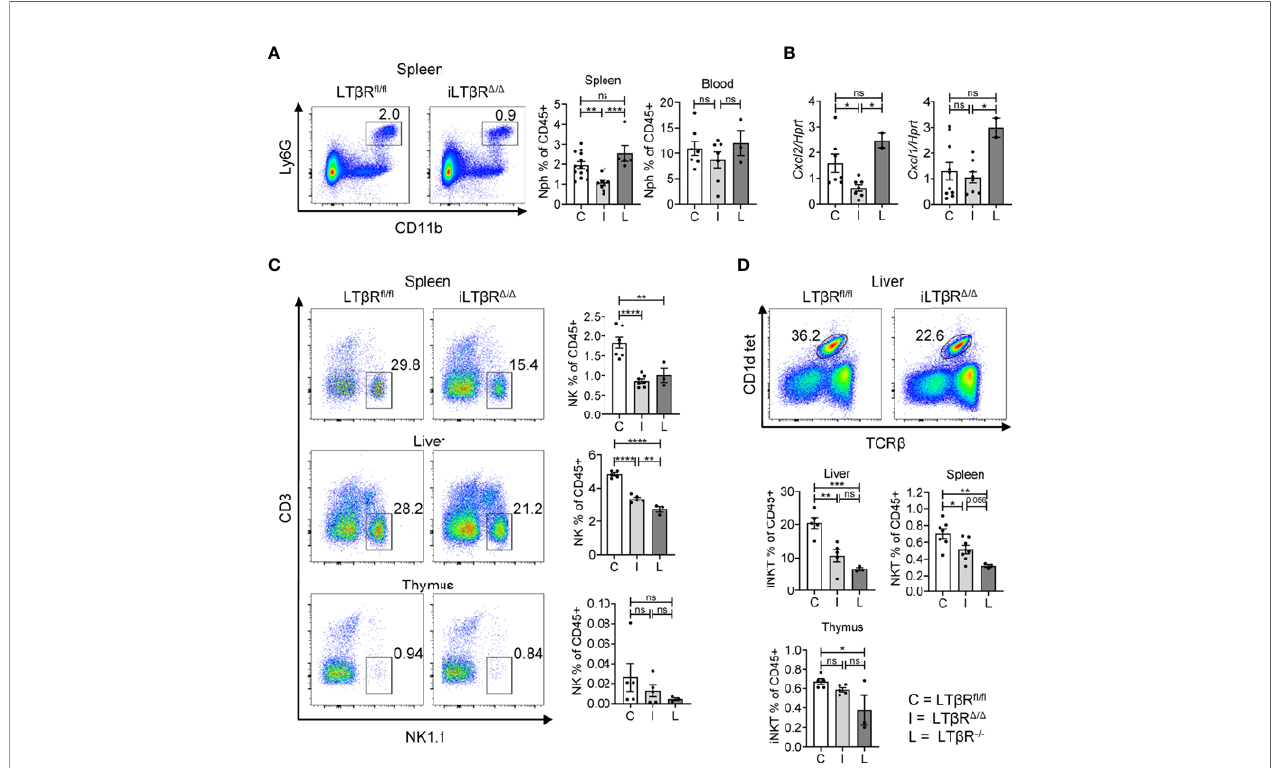
FIGURE 4 | Impact of LT b R signaling in adulthood on homeostasis of neutrophils, NK, and iNKT cells. LT b R fl / fl (C) and iLT b R D / D (I) mice were treated by oral gavage with oil or TAM one month before analysis. (A) Representative fl ow cytometry plots of neutrophils (Nph) in the spleens of iLT b R D / D and LT b R fl / fl mice. Graphs show % of Ly6G + Lin - CD11b + neutrophils in CD45 + gate for spleens and blood. (B) Expression of CXCL1 and CXCL2 in the spleen measured by qPCR. For panels (A, B) , data shown is combined from 3 experiments. N=2-13 per genotype. (C) Representative fl ow cytometry plots of NK1.1 + NK cells in the spleen, liver, and thymus from iLT b R D / D and LT b R fl / fl mice. Right panels indicate % of NK cell frequencies in the CD45 + populations from spleen, liver, and thymus. (D) Representative fl ow cytometry plots of CD1d tet + TCR b + iNKT cells in the liver. Graphs show % of iNKT cell frequencies in the CD45 + populations of liver, thymus, and spleen. For panels (C, D) , data shown is from two of three independent experiments. Signi fi cance was determined using one-way ANOVA with Tukey ’ s correction for multiple comparisons. All gating strategies are de fi ned in Figure S2 . Data shown are means ± SEM. Bars show the mean, symbols represent individual mice. Not signi fi cant (ns, p > 0.05), *p < 0.05, **p < 0.01, ***p < 0.001, ****p <